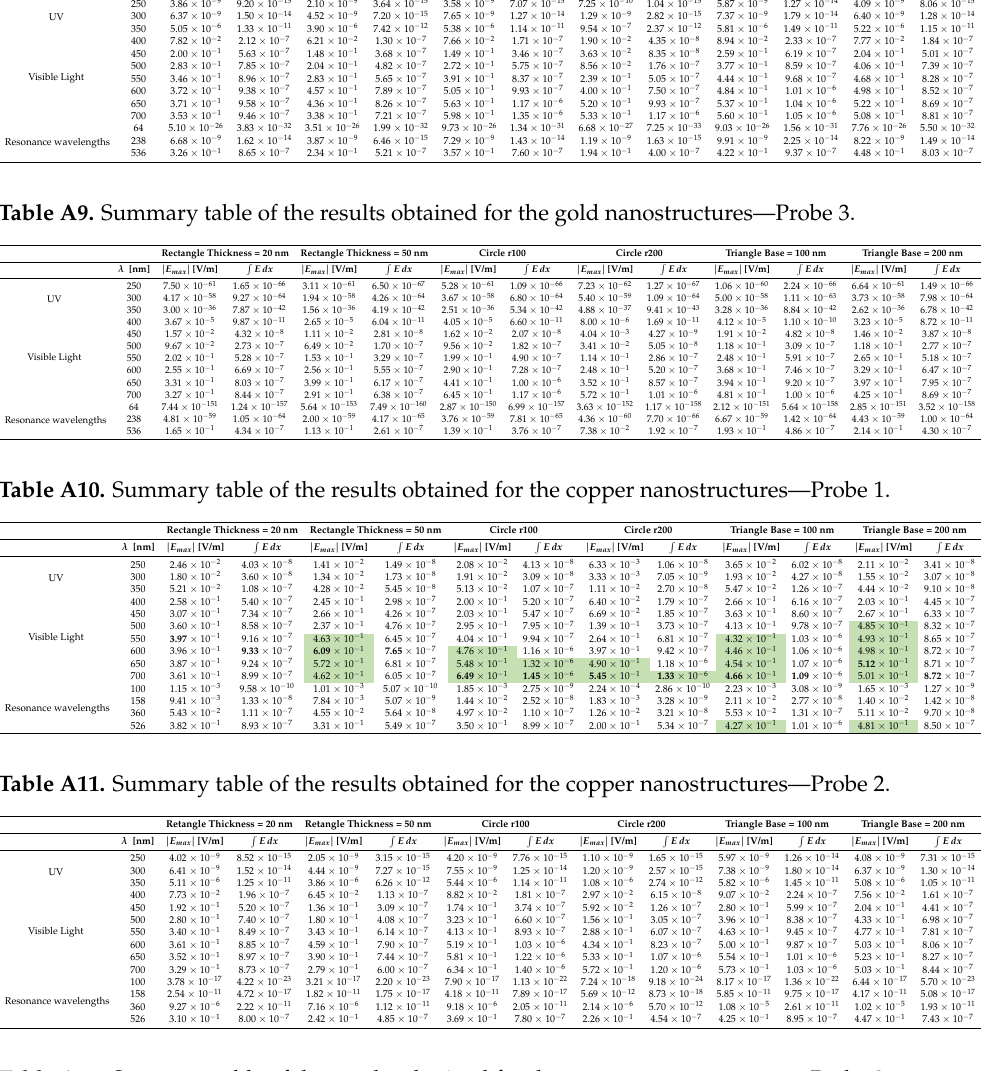
Table A12. Summary table of the results obtained for the copper nanostructures—Probe